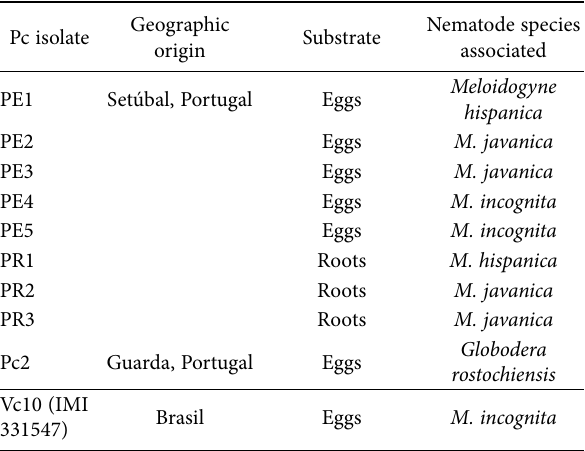
Table 1. Pochonia chlamydosporia var. chlamydosporia isolates, geo- graphic origin, substrate and associated nematode